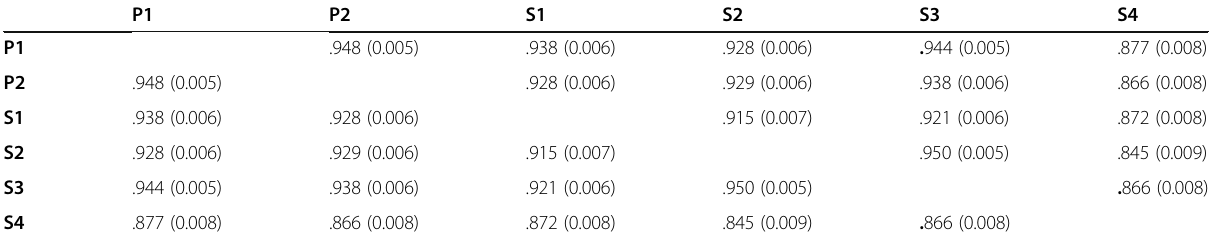
Table 3 Pairwise agreement κ between observers (approximate significance) a P1